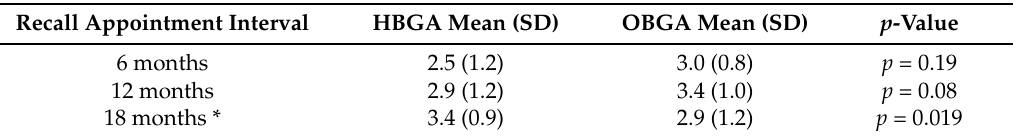
Table 3. Mean Frankl scores at follow-up